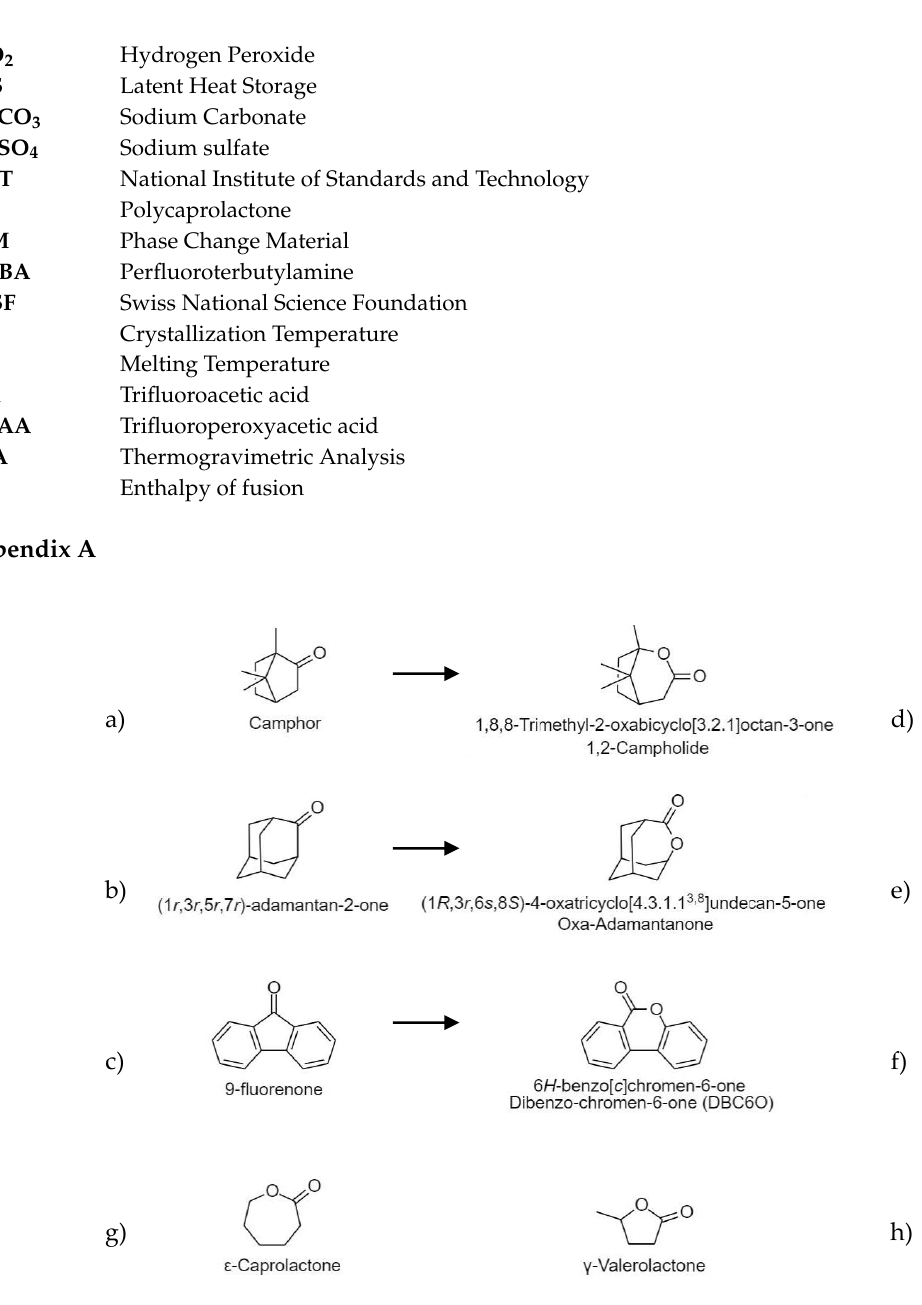
Figure A1. Structures, IUPAC and given names of precursor cyclic ketones ( a , b , c ), the relative lactones produced ( d , e , f ) and the commercial lactones studied ( g , h